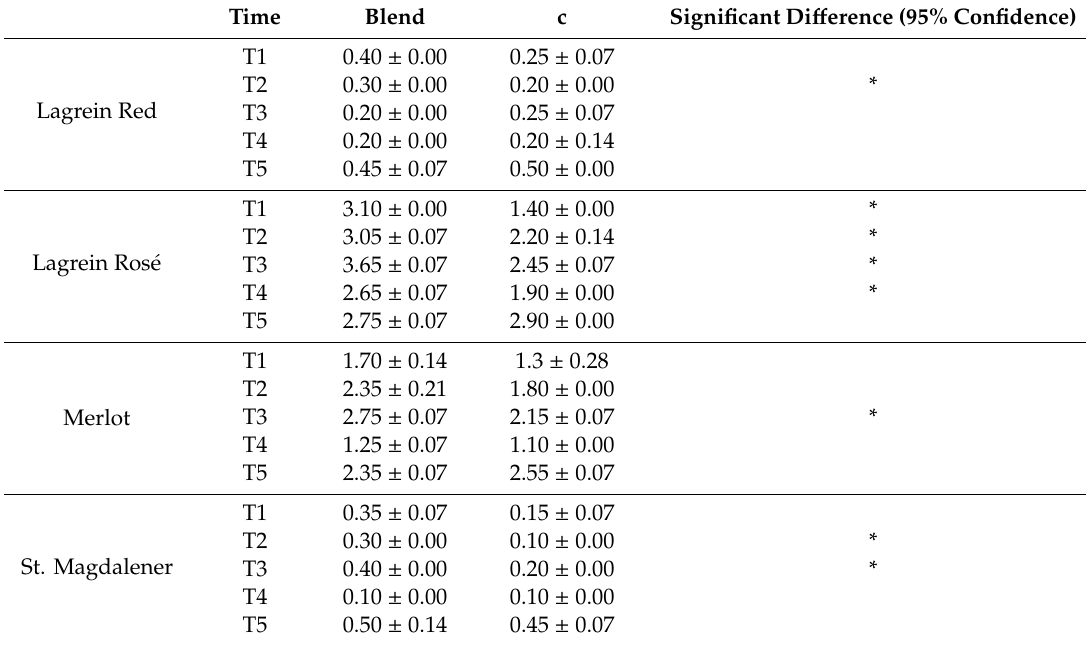
Table 3. Dissolved oxygen (mg L − 1